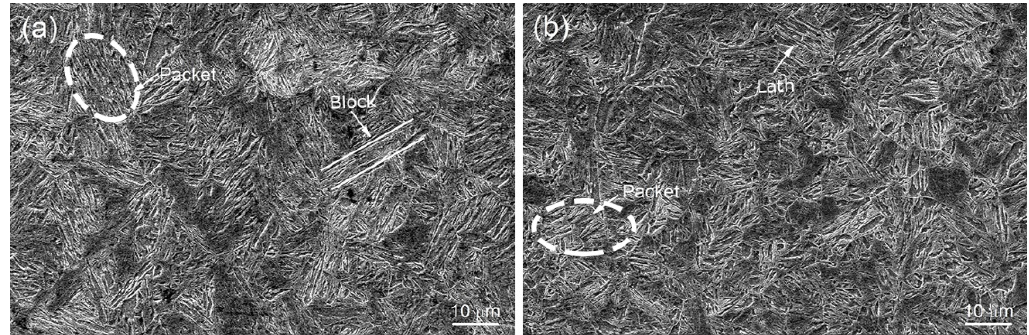
Figure 2. SEM micrographs show the martensite packets, blocks and laths of ( a ) TB0 and ( b ) TB1 steels after quenching and tempering (Q+T).